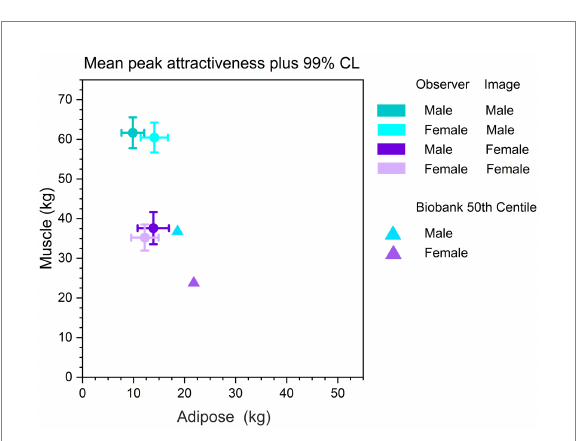
FIGURE 4 Circles show locations in body composition space for the most attractive bodies, shown separately for images of male and female bodies, and male and female observers. The error bars correspond to 99% confidence intervals for both body fat and skeletal muscle mass. The triangles represent the 50th centiles of total skeletal muscle mass and body fat for adult White males and females in the UK